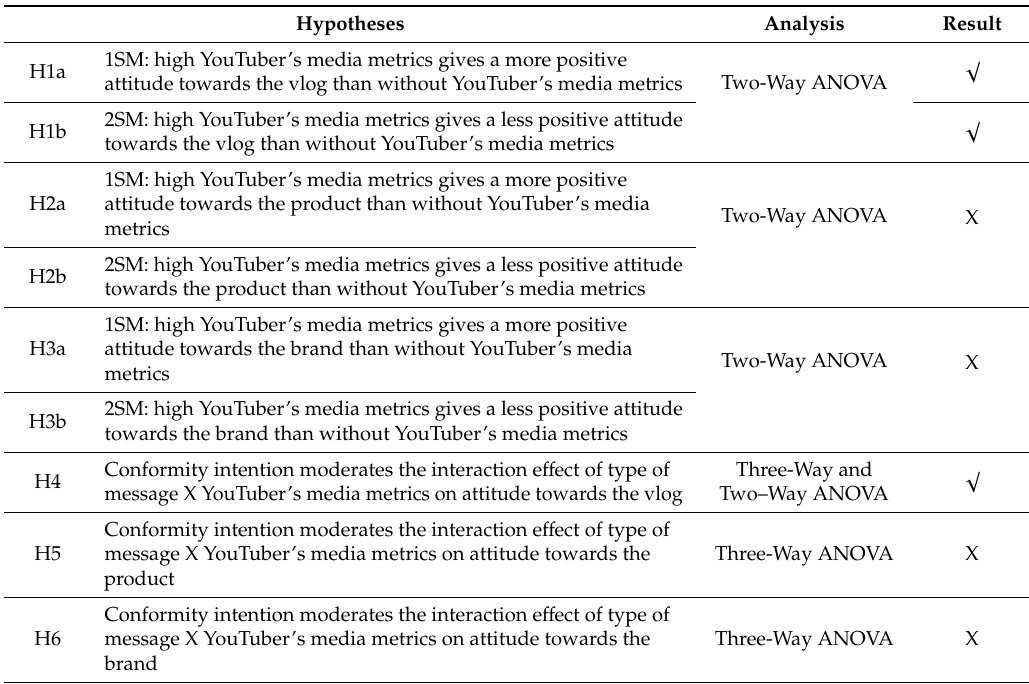
Table 1. Hypotheses, analytical techniques, and